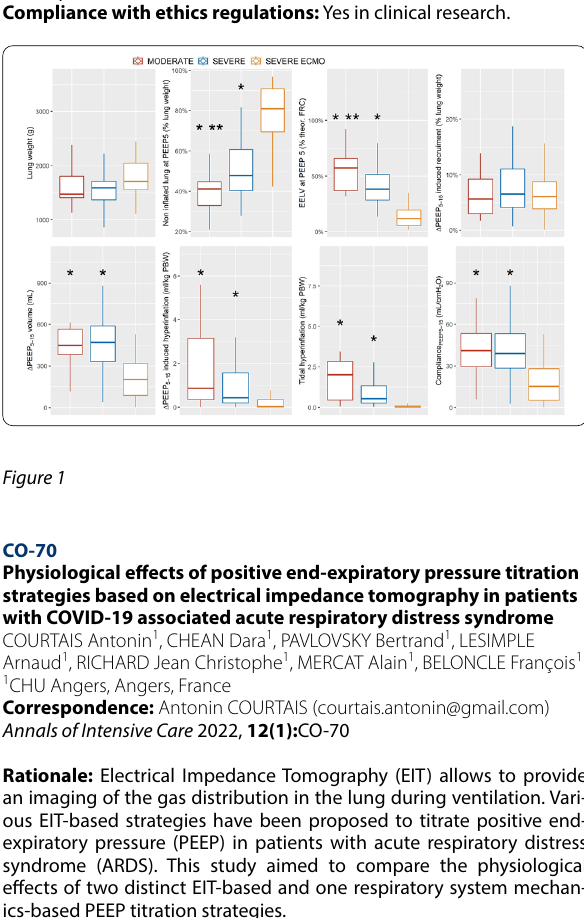
CO‑70 Physiological effects of positive end‑expiratory pressure titration strategies based on electrical impedance tomography in patients with COVID‑19 associated acute respiratory distress